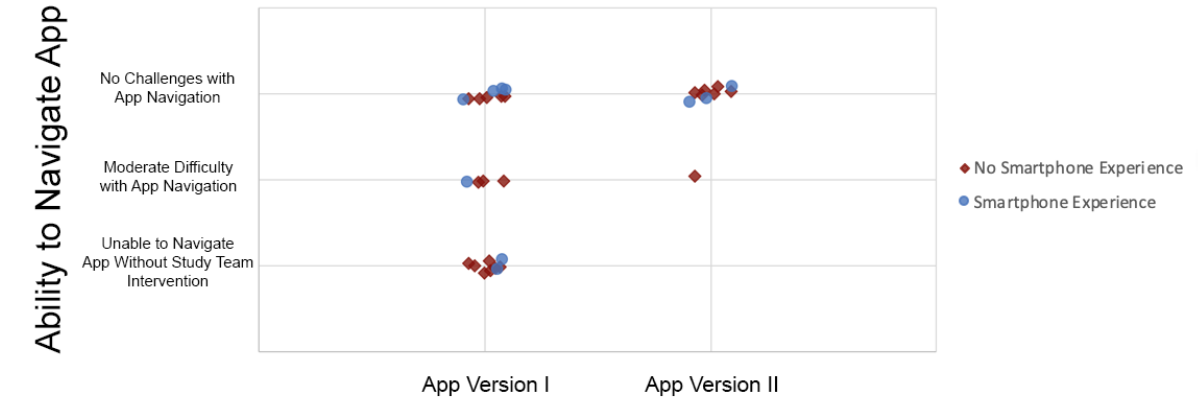
Figure 3. Comparison of mothers' ability to navigate version I and version II of the app based on previous smartphone experience. Mothers using version II of the app showed a significant improvement in app navigation ( P =.02).